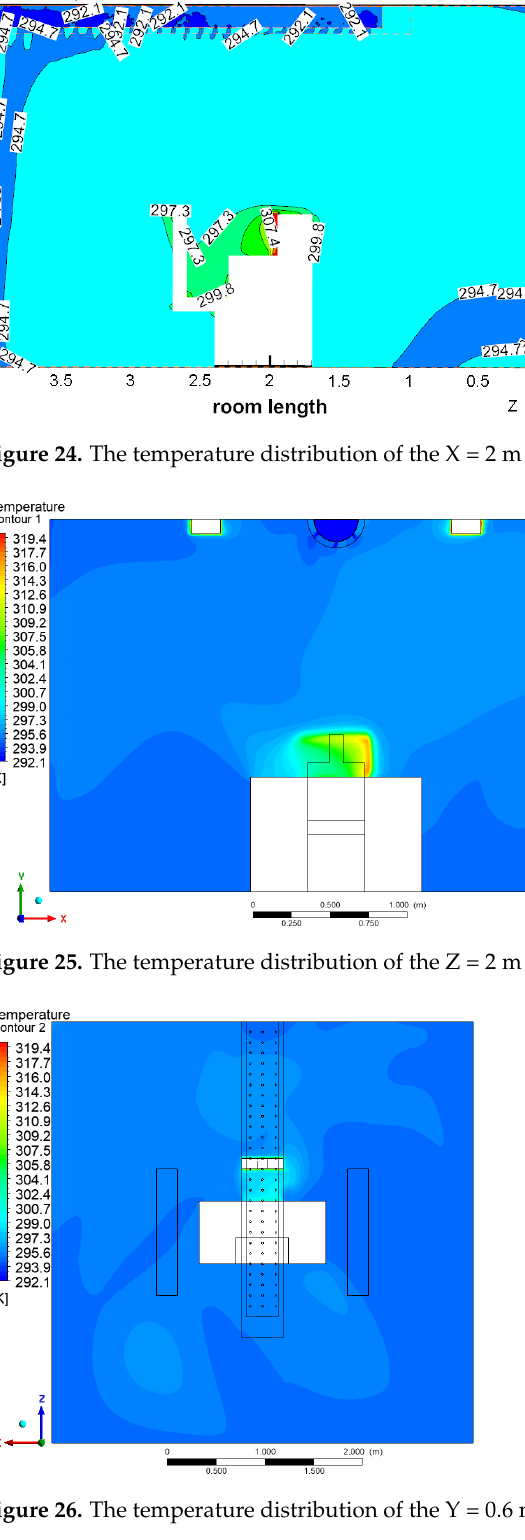
Figure 27. The temperature distribution of the X = 2 m section. Figure 28. The temperature distribution of the Z = 2 m section.